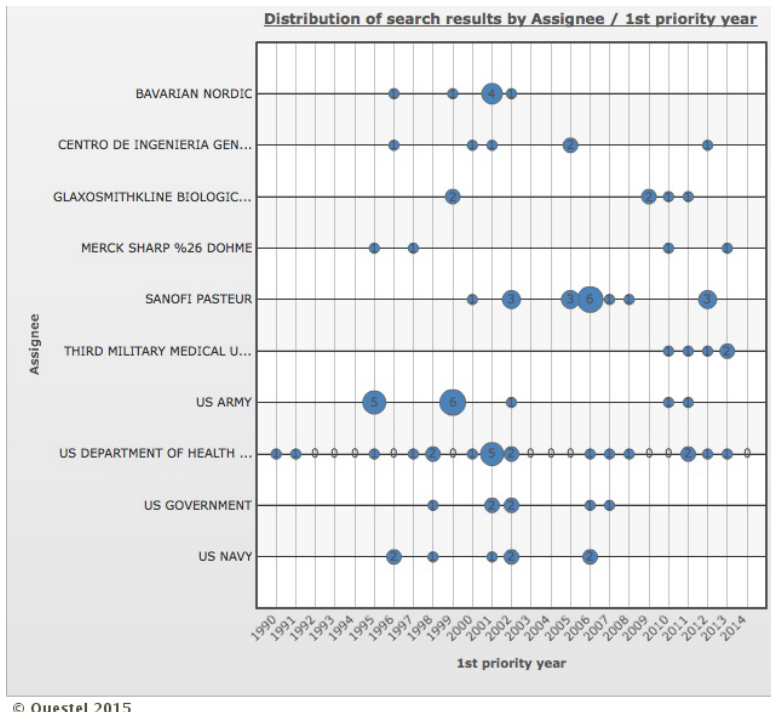
Figure 6. Distribution of search results by the correlation between first priority year and top 10 holders. Holders: Bavarian Nordic, Centro de Ingenieria Genetica